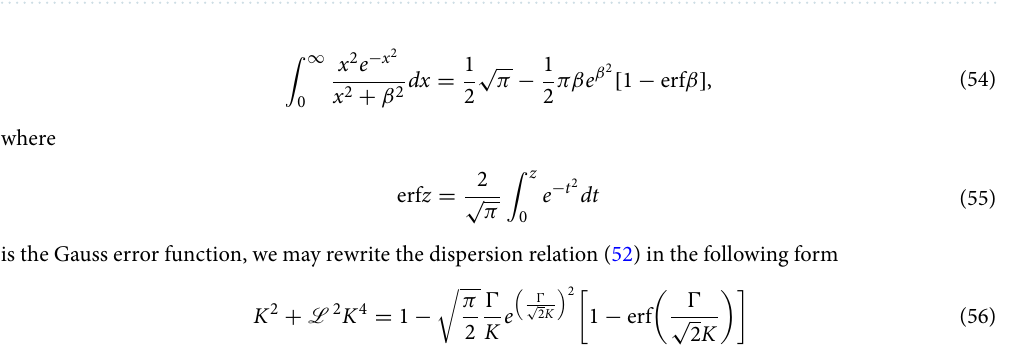
Figure 4. The growth rate corresponding to the numerical solution of Eq. (56) for Newtonian gravity (solid 0.1 (dashed line) and first gradient gravity with L =